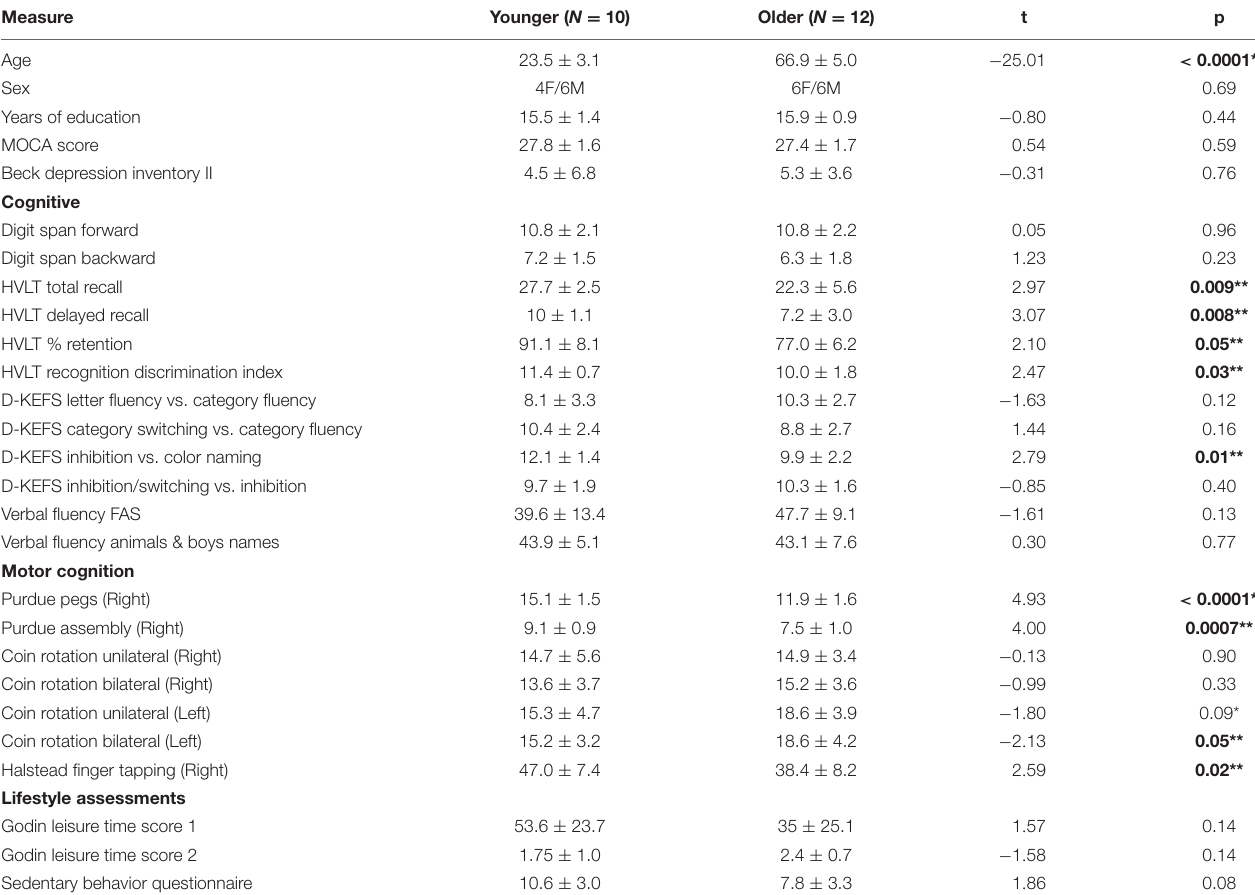
TABLE 1 | Summary of group-level demographic and behavioral